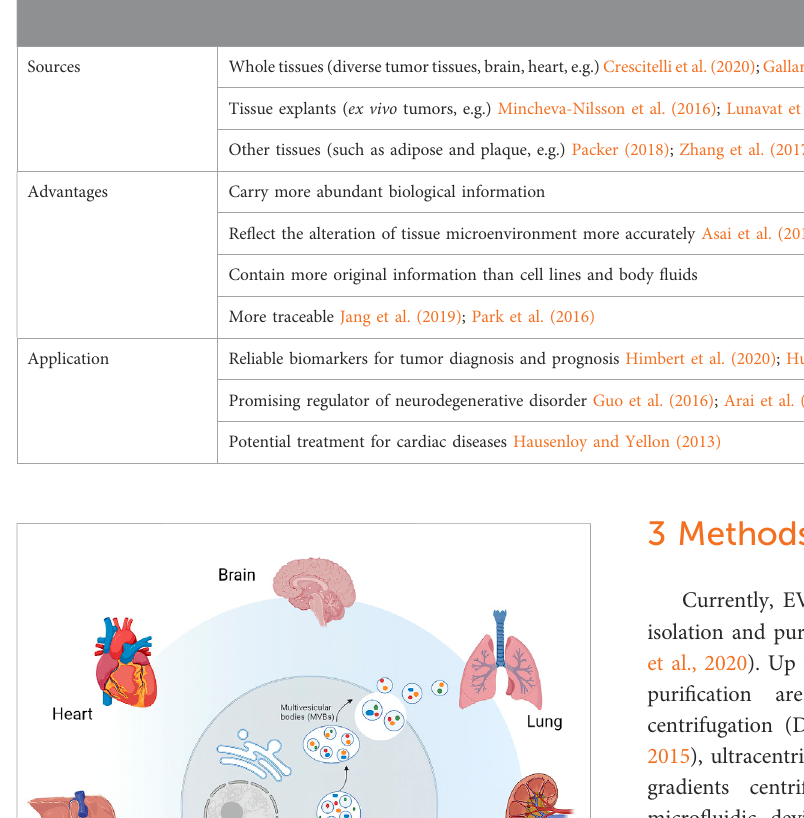
TABLE 1 Characteristics of Ti-EVs.